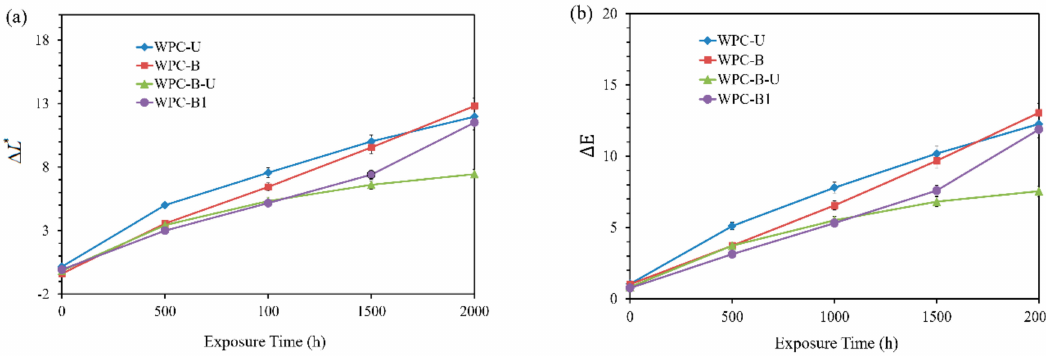
Figure 3. Color parameters, the composites surface at different weathering stages. ( a ) ∆ L ∗ , and ( b ) ∆ E